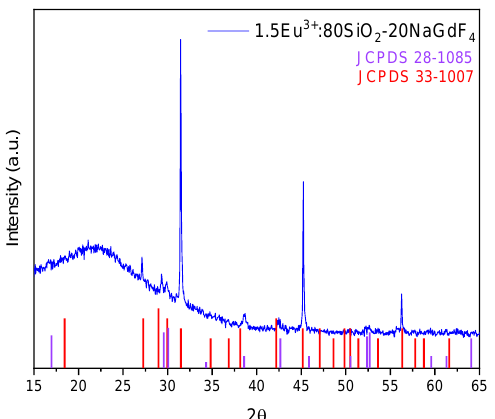
Figure 3. XRD pattern of OxGCs with the composition 80SiO 2 -20(1.5Eu 3+ : NaGdF 4 ) heat-treated at 450 °C for 5 h.